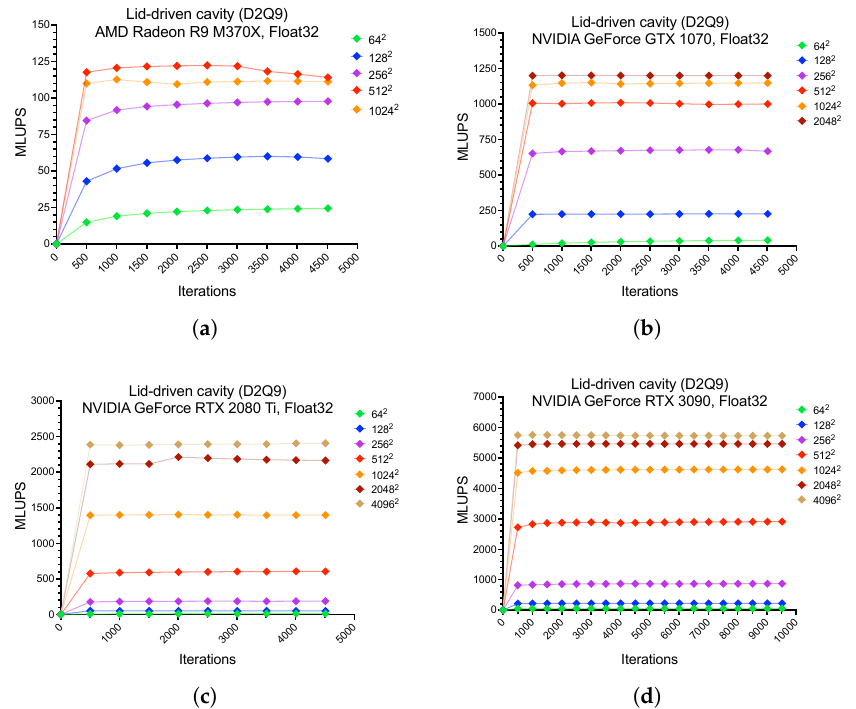
Figure 5. Single-precision performance analysis of 2D lid-driven cavity on D2Q9 stencil. ( a ) Perfor- mance on Radeon R9 M370X GPU; ( b ) Performance on GTX 1070 GPU; ( c ) Performance on RTX 2080 Ti GPU; ( d ) Performance on RTX 3090 GPU.